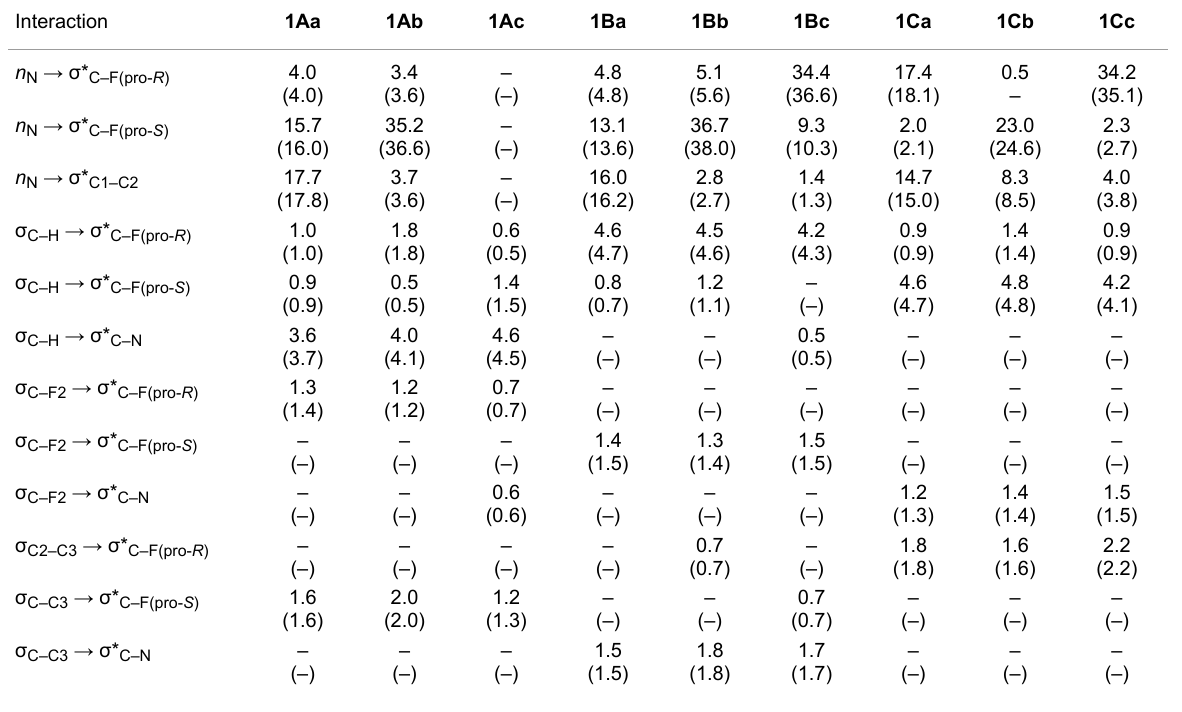
Table 3: Natural bond orbital (NBO) energies (in kcal mol − 1 ) for 1 in implicit cyclohexane and pyridine (second entries, in parenthesis) solutions.